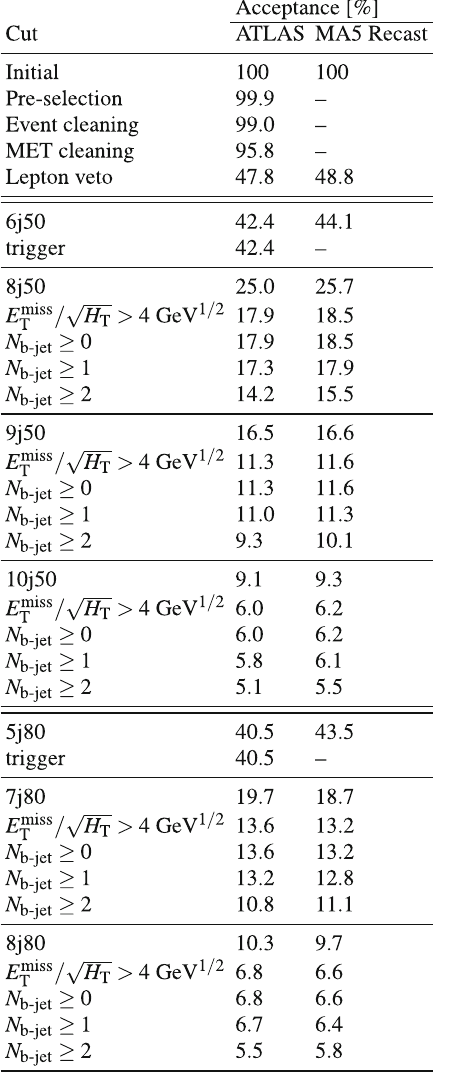
Table 6 Cutflow comparison for 7–10 jets analysis using pMSSM slice signal. Signal regions are defined by the jet multiplicities and b-tagging